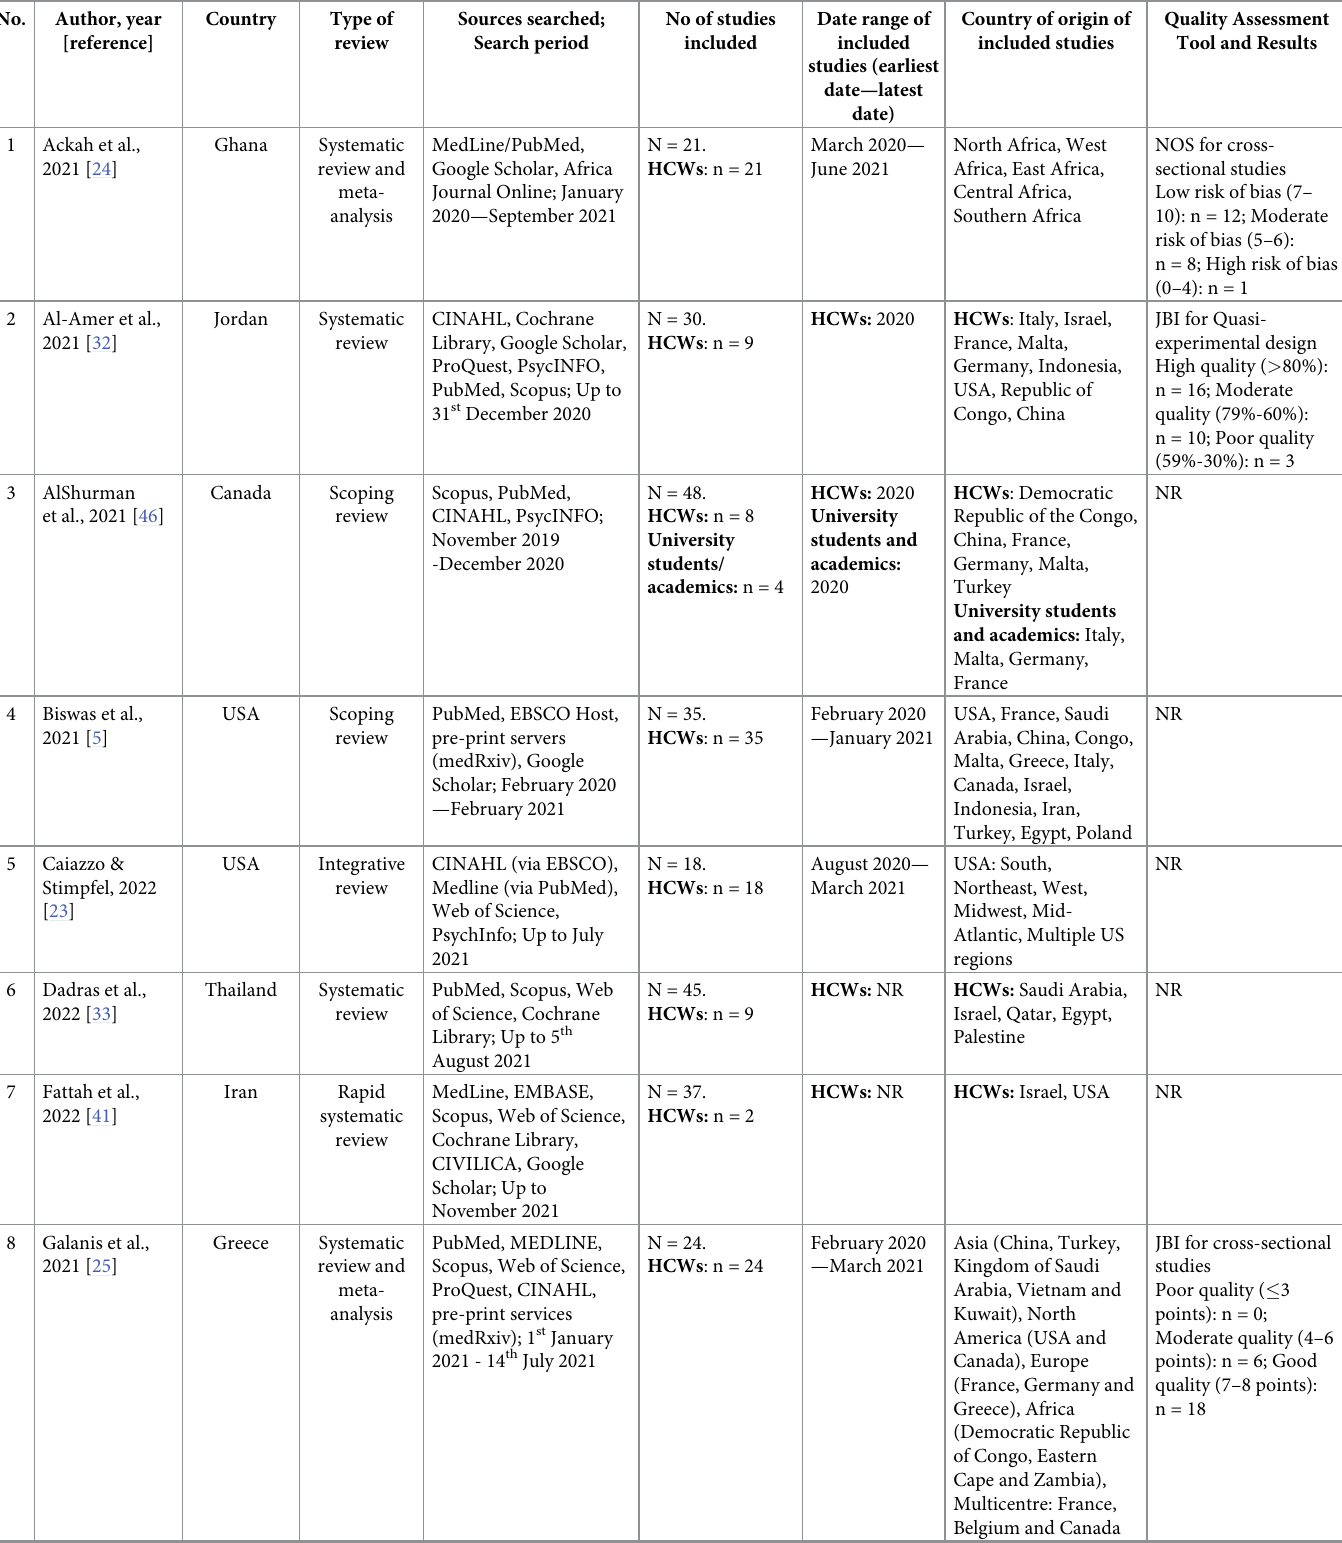
Table 3. Main characteristics of studies included in the Umbrella